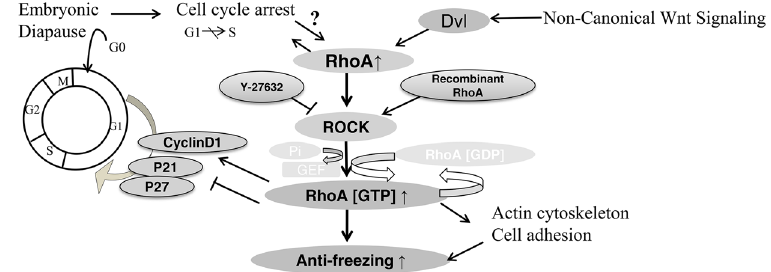
Figure 3. Schematic diagram showing the RhoA pathway in cryopreservation of dormant murine embryos. The RhoA/ROCK pathway may improve the anti-freezing capacity of embryos, through two signalling pathways: embryonic diapause and non-canonical Wnt